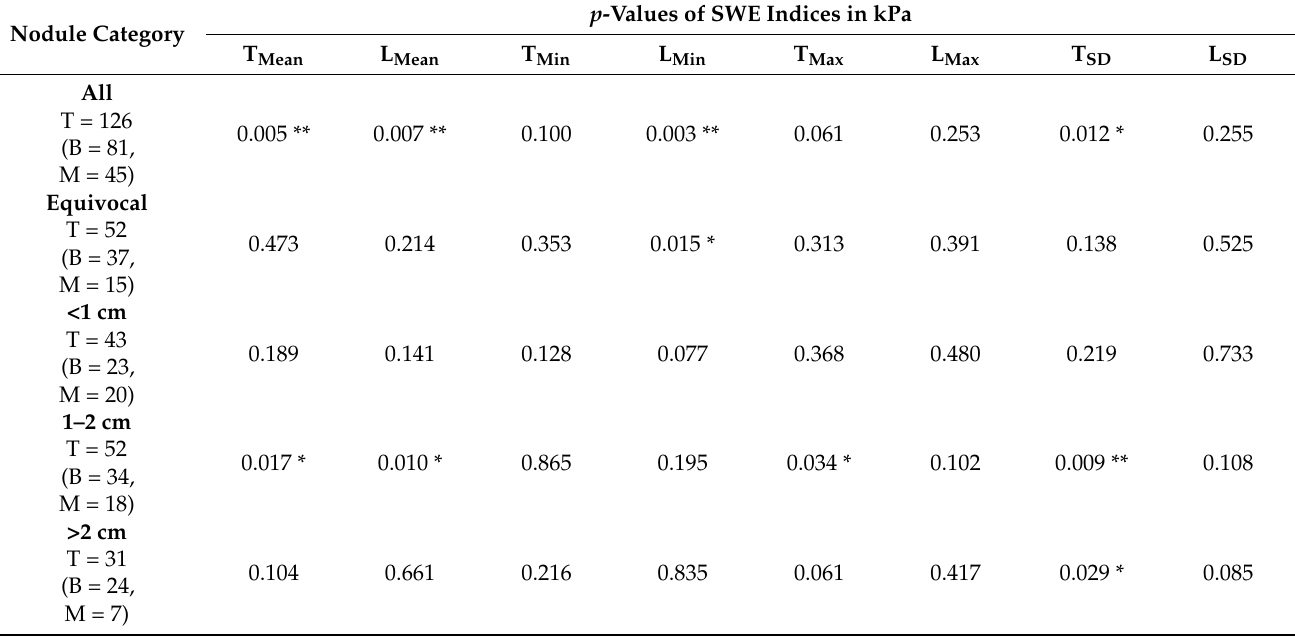
Table 2. Statistical significance assessment for the differences in SWE indices between benign and malignant thyroid nodules based on the scan